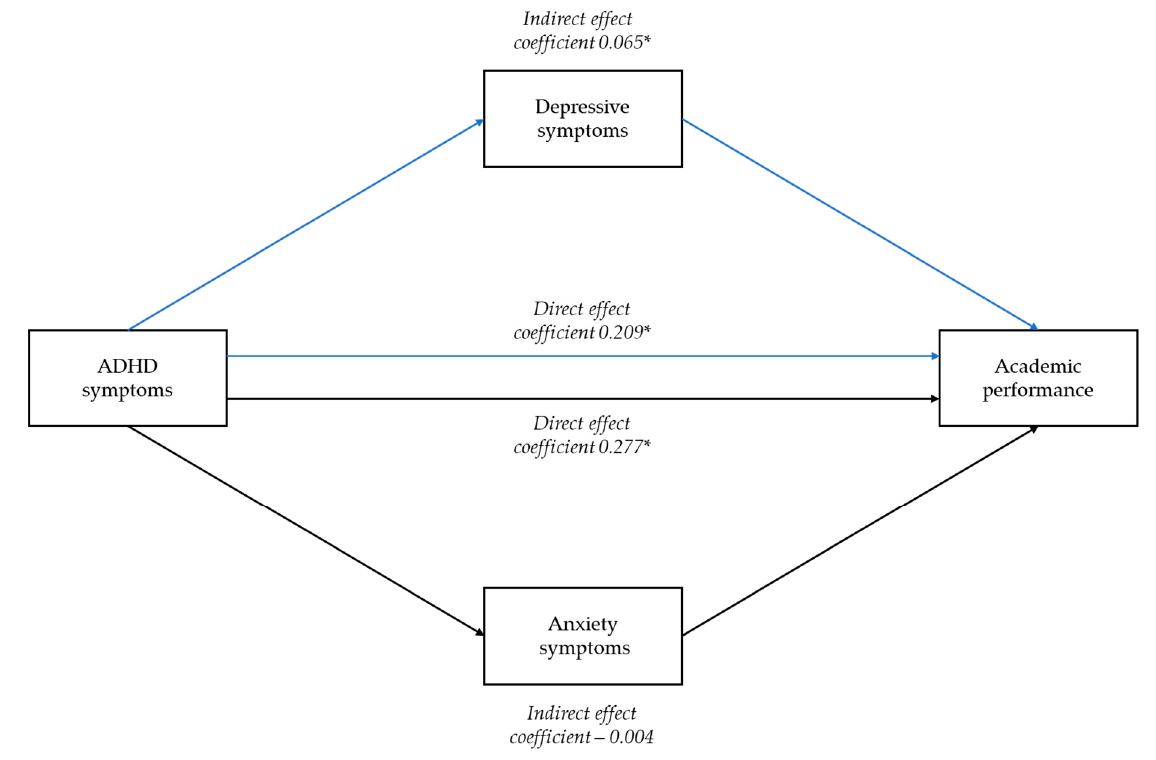
Figure 1. Path diagram of the mediation models between ADHD symptoms and academic performance (being on track vs. not being on track with exams). * p < 0.05.